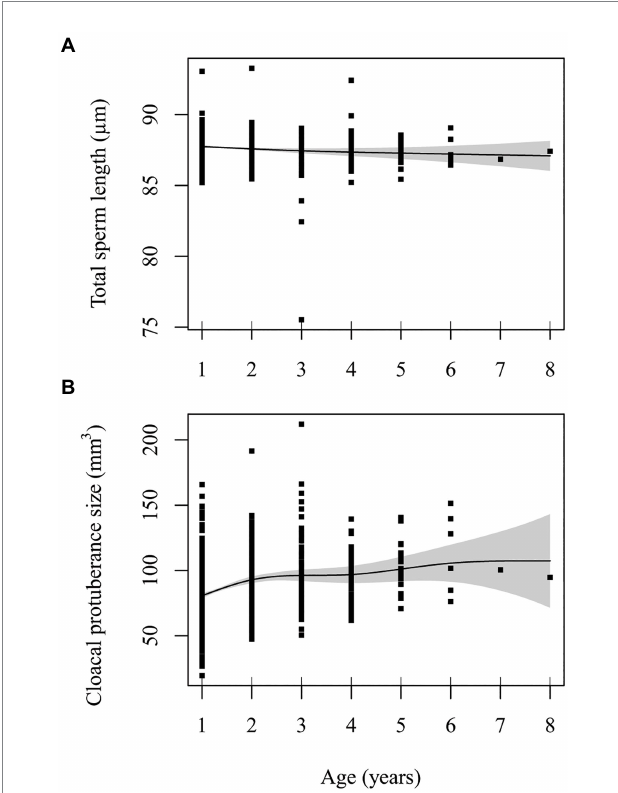
FIGURE 1 Effect of male age (years) on (A) total sperm length ( μ m) and (B) cloacal protuberance size (mm 3 ). Line is predicted value from GAMM with 95% confidence intervals. Points are partial residuals from model that included lifespan as a covariate, along with random effects of ring number (ID) and capture